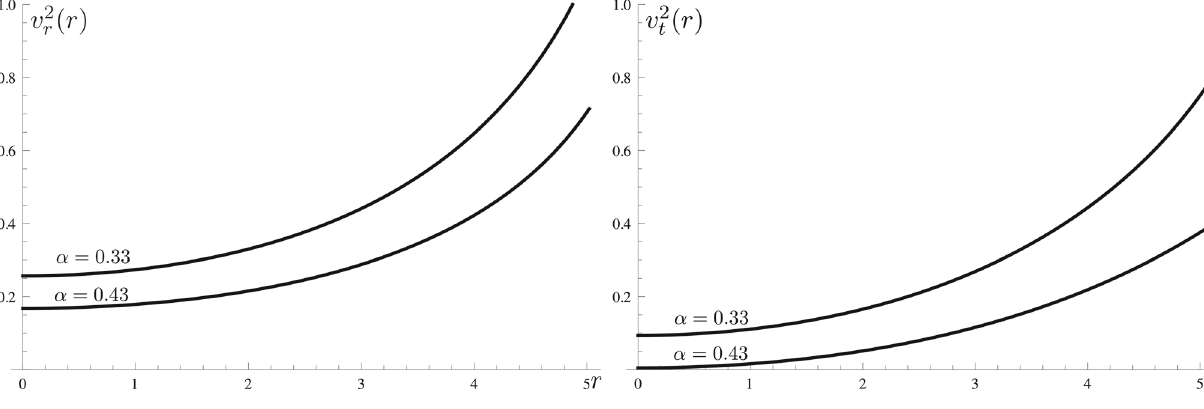
Fig. 3 Radial velocity ( v 2 r ) and tangential velocity ( v 2 t ) for a stellar system with compactness M / R = 0 . 2. Radial coordinates are in units of M ( r = 5 = R ) . The cosmological constant (cid:5) ∼ 10 − 52 is too small to be